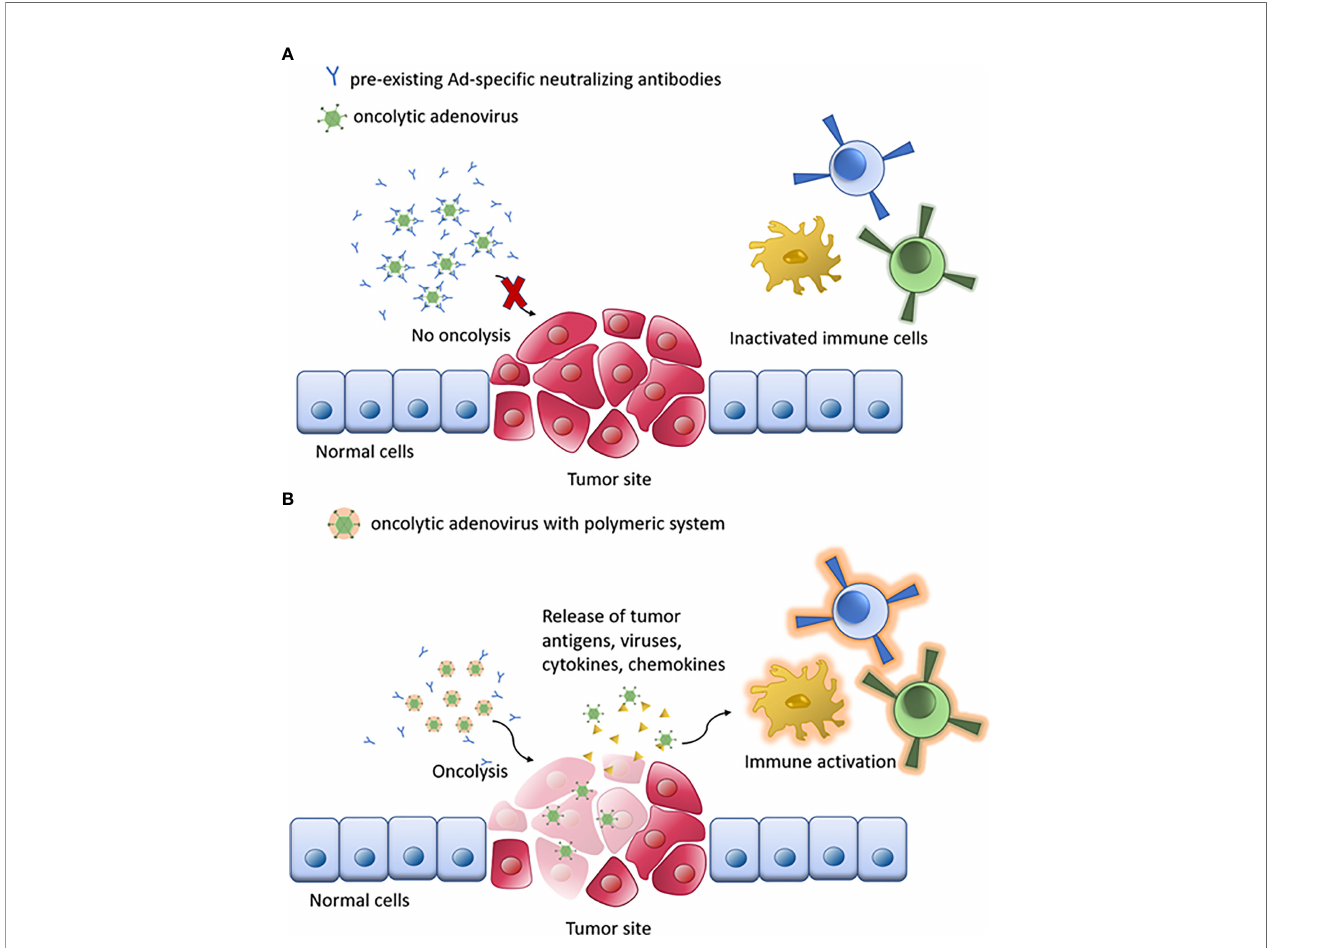
FIGURE 4 | Schematic of oAd immunotherapy with polymeric system. (A) The naked oAd is disabled by pre-existing Ad-speci fi c neutralizing antibodies. (B) Oncolysis by polymer/oAd system stimulates the immune system response against tumor cells, enhancing the therapeutic